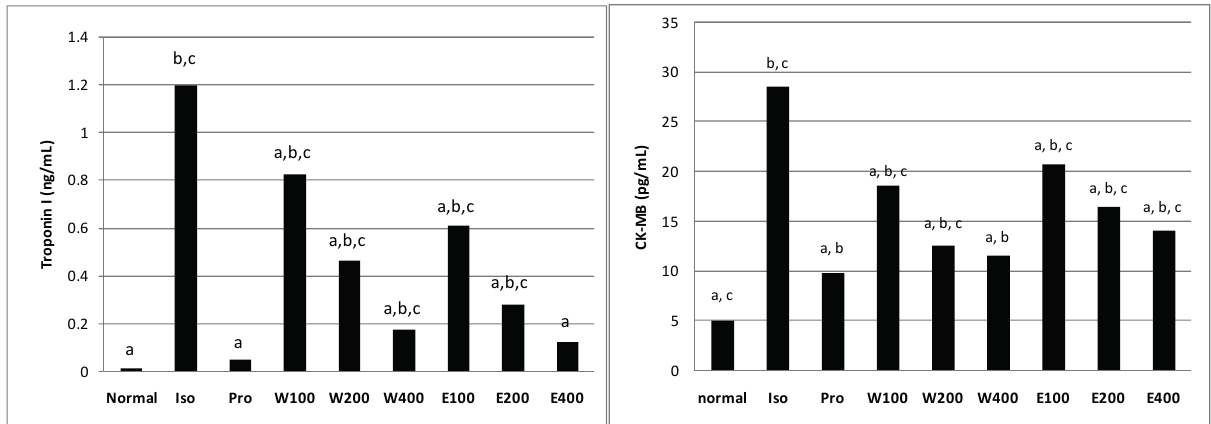
Figure 3. Effect of the aqueous and 80% ethanol extracts of Labisia pumila var. alata at different concentrations on serum troponin I (cTnI) and CK-MB isoenzyme in normal control and experimental myocardial infarction rats. ISO = isoproterenol, Pro = propranolol. a Significantly different to isoproterenol-induced (negative control) group at p < 0.05; b Significantly different to normal group at p < 0.05; c Significantly different to propranolol (positive control) group at p <